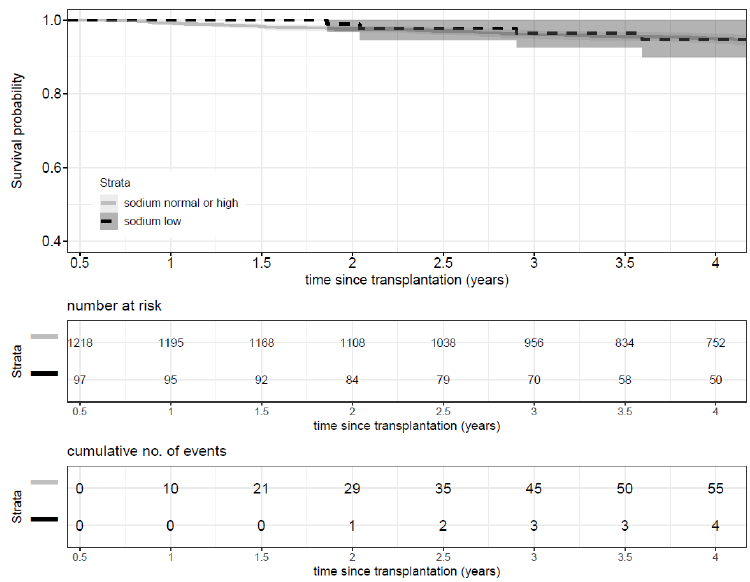
Figure 2. Kaplan Meier curve of outcome of death by sodium level. Hyponatremia at baseline was not associated with rapid decline of renal function, graft loss or death (log rank test p = 0.9). Figure 3 shows the Kaplan-Meier risk curves of composite outcome (rapid decline of renal function, graft loss or death). At 15 months, the secondary composite outcome occurred in 30.9% (30/97) of hyponatremic patients, and 34.1% (415/1218) in patients with natremia ≥ 136 mmol/L.